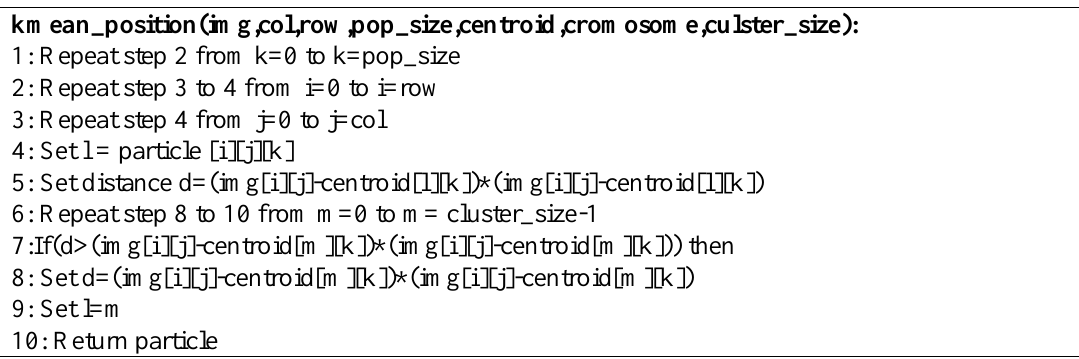
Algorithm 8 is used to determine the current position of the particle by K-means algorithm equation (1) and (2). In this algorithm, distance of each pixel from all centroid of the image is calculated and the pixel is assigned to that segment that has a minimum distance from its centroid. In the Algorithm 9 (Proposed Algorithm CHDPSOK) all the function is called and update the position using the velocity of each particle by equation (7) and update the position of each particle using K-means iteration using the equation (1) and (2). Repeat the entire step until certain criteria are met. Here certain criteria are the maximum number of iteration. Once a criterion is met particle with the global best position will be our final solution and the pixel value of this particle with segmentation is updated to the final segmented